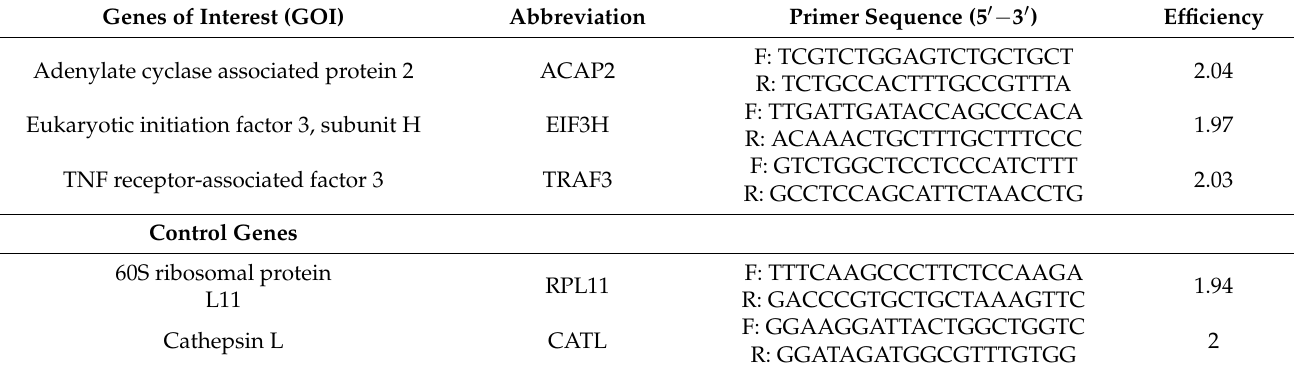
Table 2. The amplification efficiency, primer sequences of each gene of interest (GOI), and control genes are presented in the